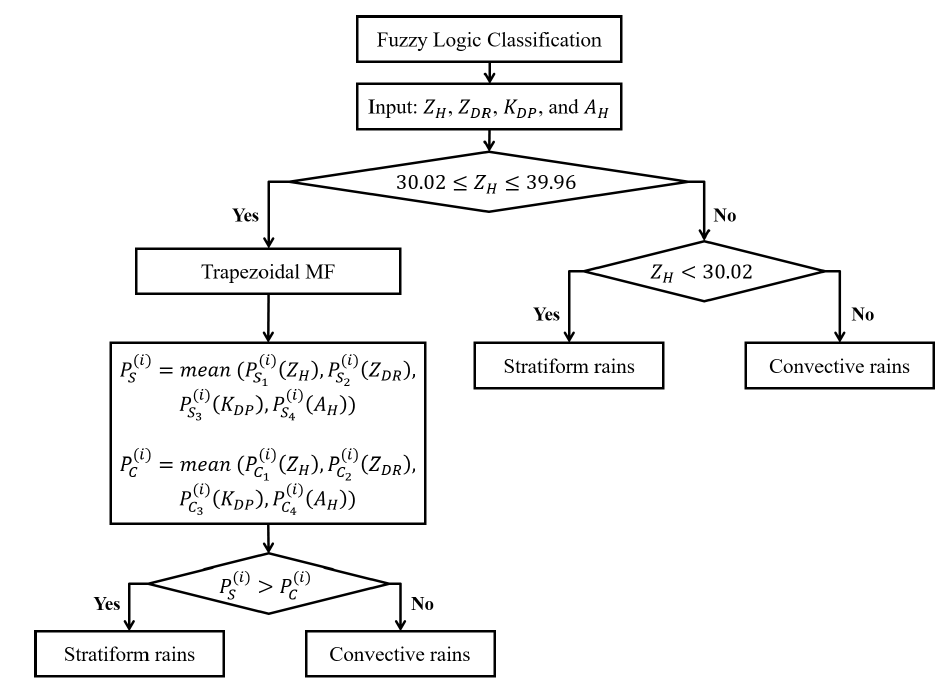
Figure 5. Flowchart for rainfall classification through the fuzzy logic